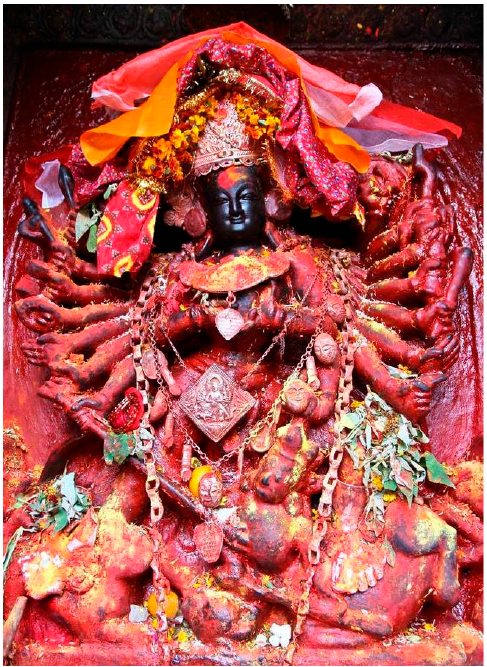
Figure 1. Durg ā Mahi ṣā suramardin ī . Figure 1. Durg¯a Mahis .